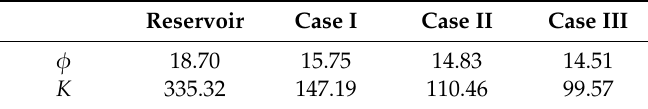
Table 3. Changes in porosity ( φ ) and permeability ( K ) for all three cases.